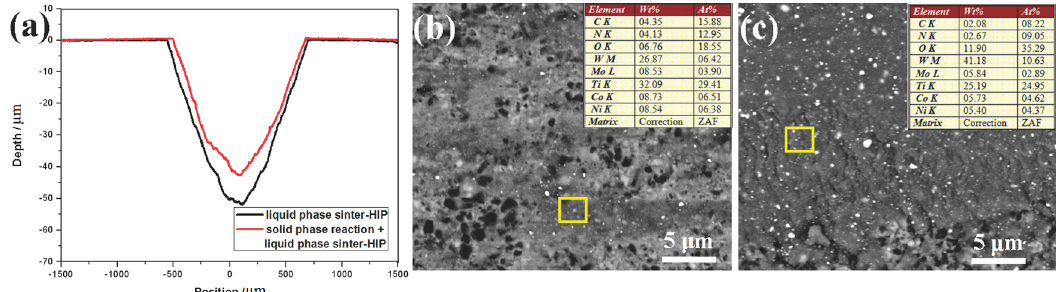
Figure 3. The wear depth of cermets ( a ) and SEM images of the wear track for cermets with the direct liquid phase sinter-HIP ( b ) and extra solid phase reaction ( c ).